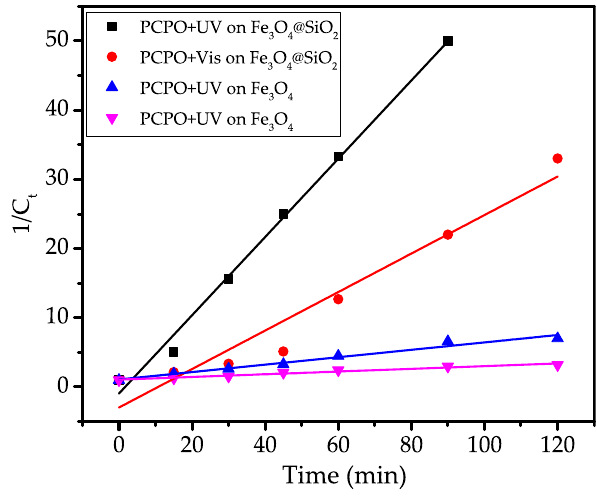
Figure 7: Second - order plots of RhB PCPO processes over Fe 3 O 4 @SiO 2 and Fe 3 O 4 .